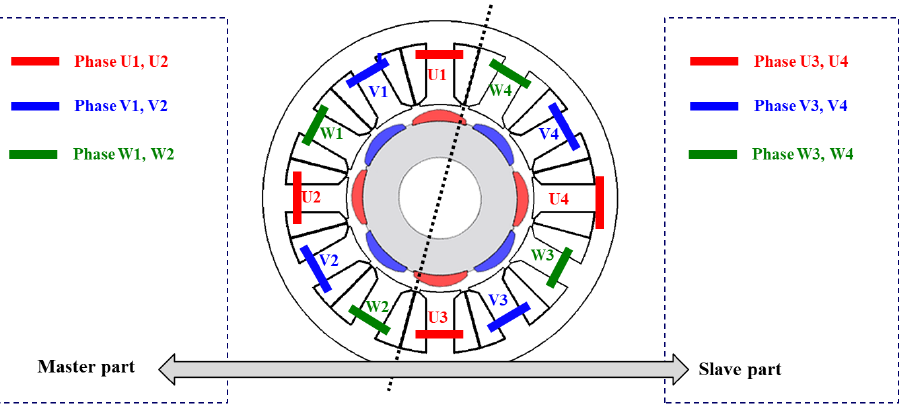
Figure 5. Configuration of conventional DWM.